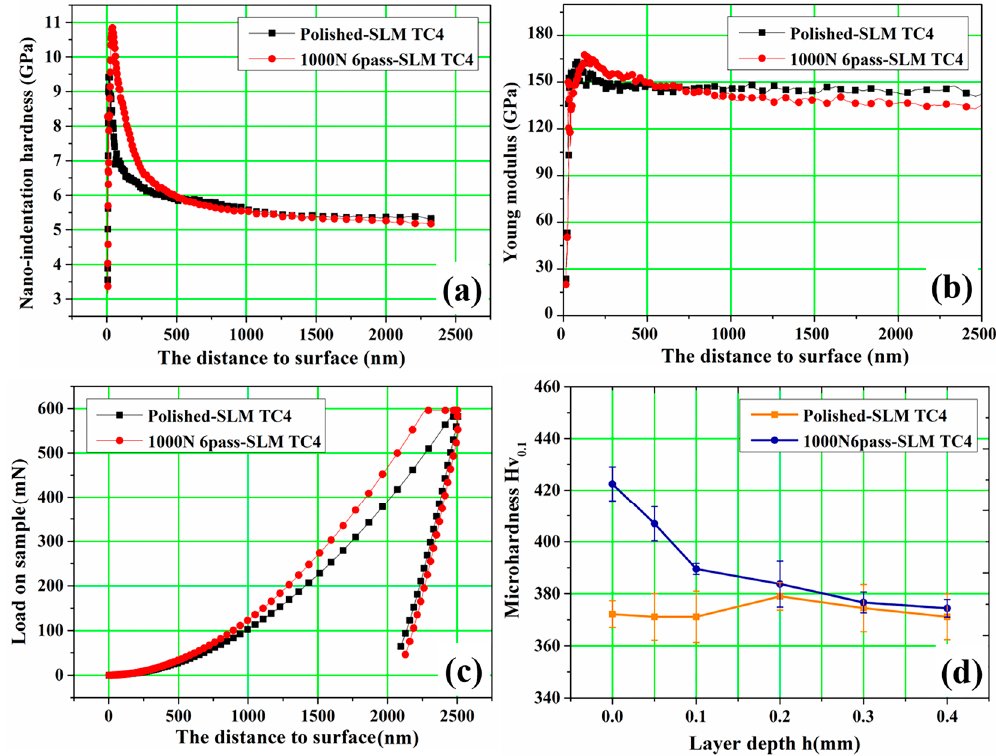
Figure 5. Nano-indentation test curves of the as-prepared and 1000 N 6 passes USRP treated samples on the top surface: ( a ) Nano-indentation hardness variation; ( b ) Young modulus variation; ( c ) Load variation and ( d ) Vickers hardness.